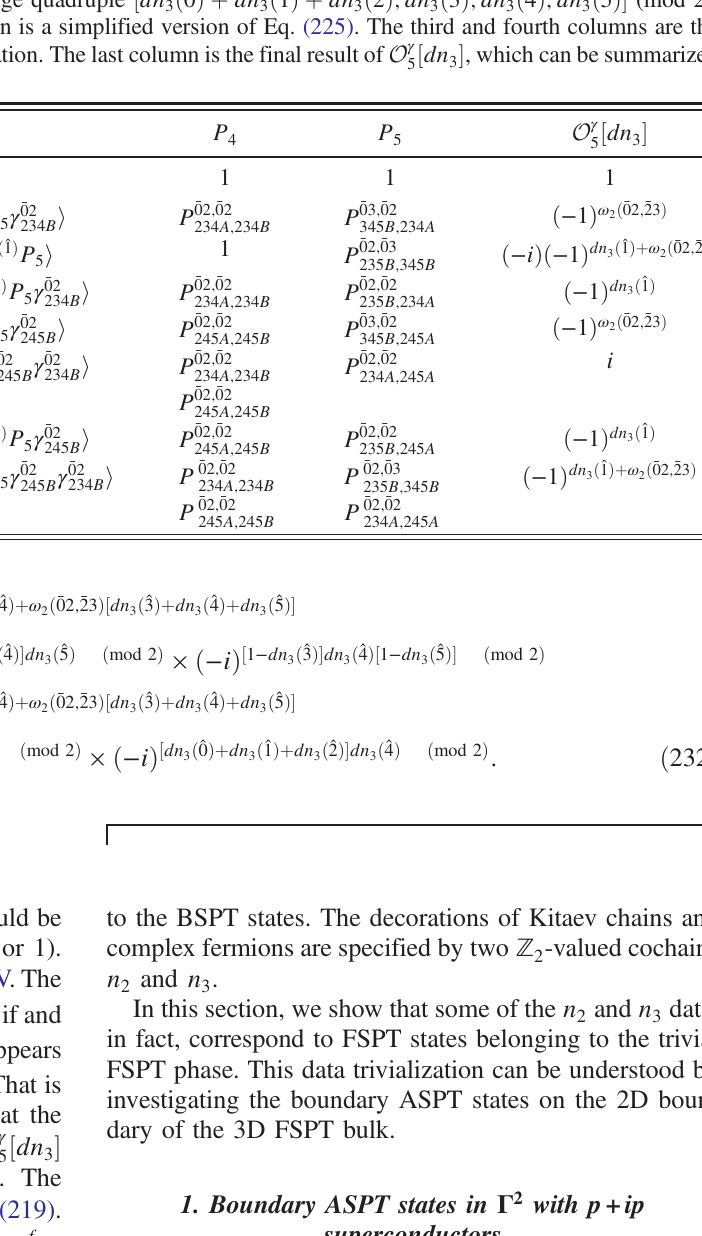
ˆ 5 ˆ 0 ˆ 1 ˆ 2 ˆ 3 ˆ 4 Þ þ dn 3 ð Þ þ dn 3 ð Þ ; dn 3 ð Þ ; dn 3 ð Þ ; dn 3 ð Þ(cid:2) (mod 2).